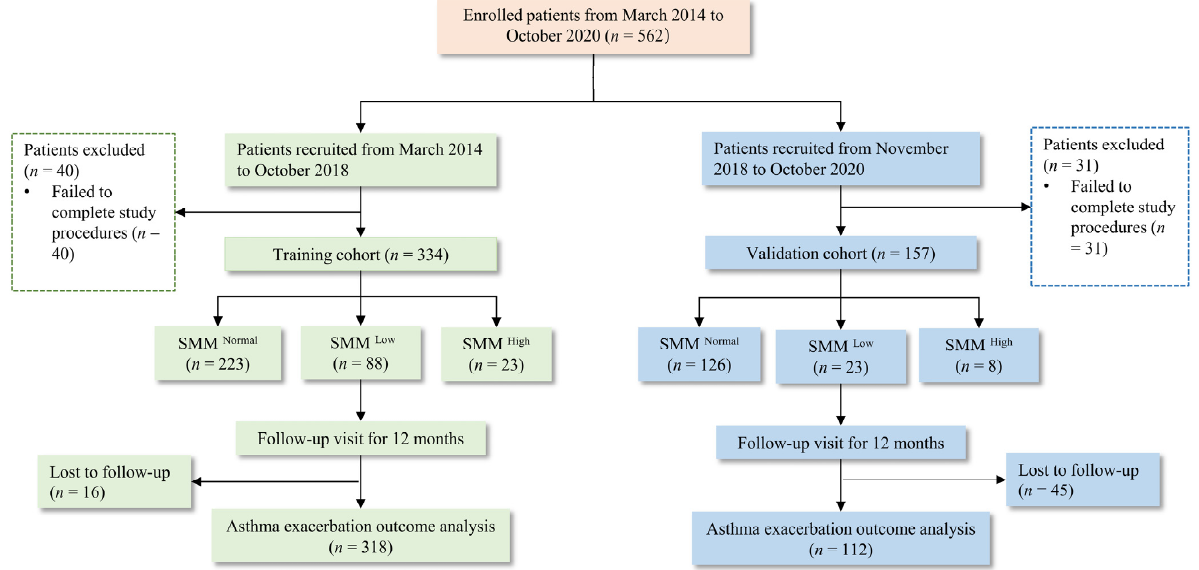
Figure 1. Flowchart for patient inclusion in the training and validation cohorts. SMM, skeletal muscle mass.